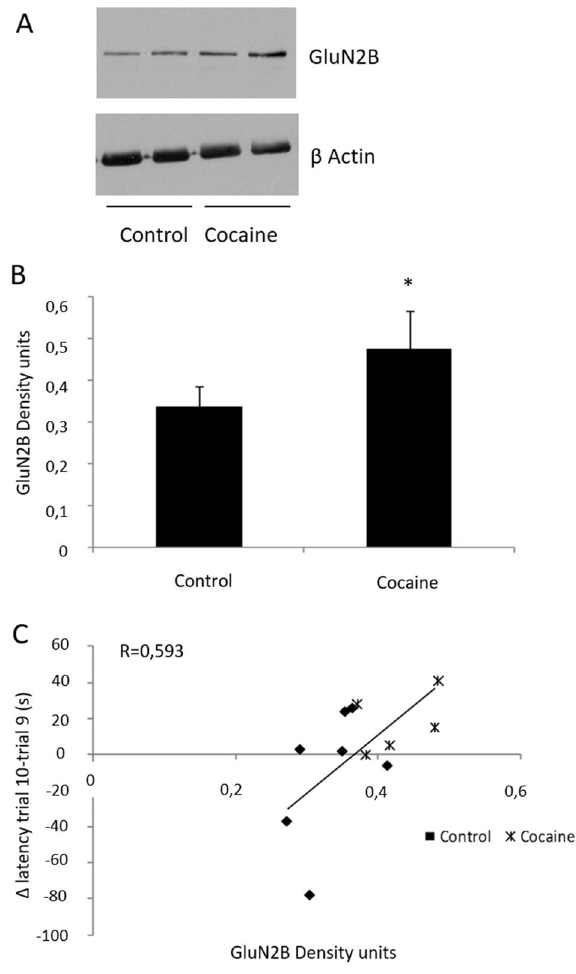
Figure 2. ( A ) GluN2B (180 kDa) and β Actin (42 kDa) western blot in hippocampus. ( B ) Representation of GluN2B density units in hippocampus. *p < 0.05 versus control group (n = 7). Full-length blots are presented in Supplementary Figure 1. Samples derive from the same experiment and that gels/blots were processed in parallel. ( C ) Significant correlation between GluN2B (density units) in the hippocampus and the difference in the latency (seconds) from trial 10- trial 9 (n =